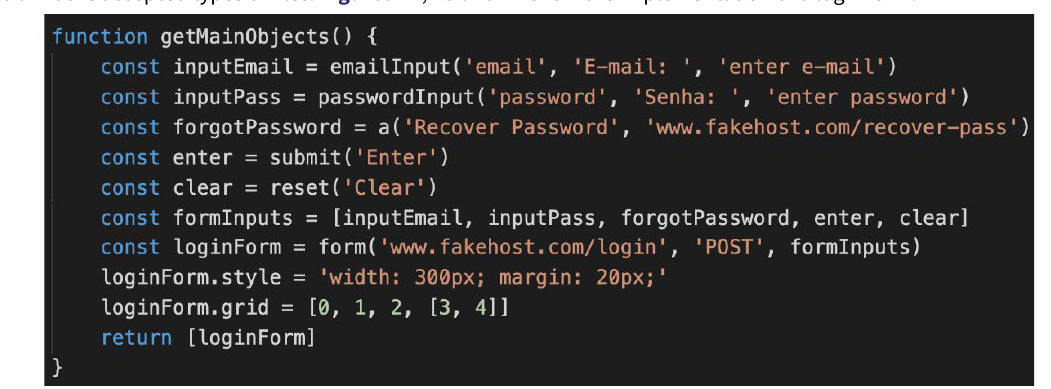
Figure 12. Implementation of the getMainObjects function to create a login form